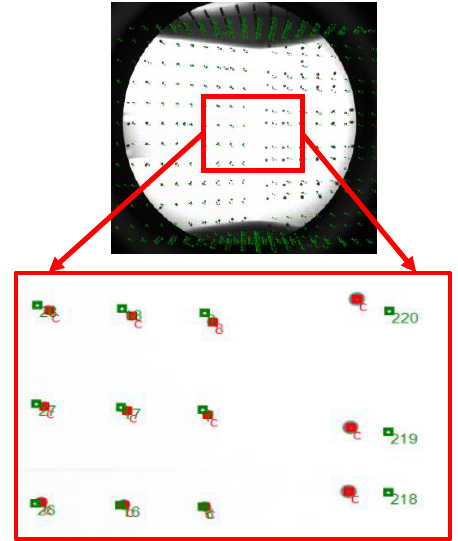
Figure 11. Projection of the targets 3D coordinates onto a calibration image (projected targets in green and the image measurements in red)